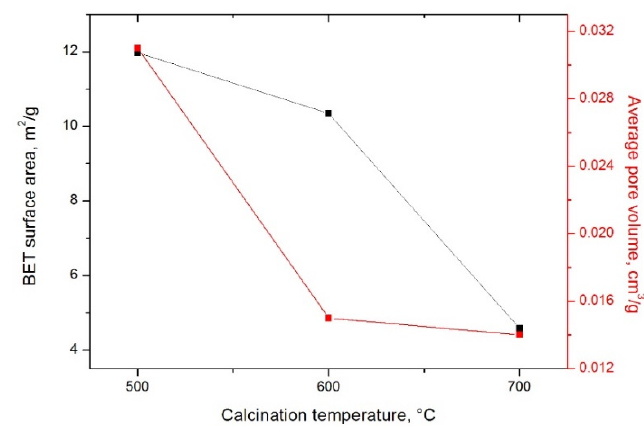
Figure 7. Influence of calcination temperature on the BET surface area and pore volume of the synthetized composites.